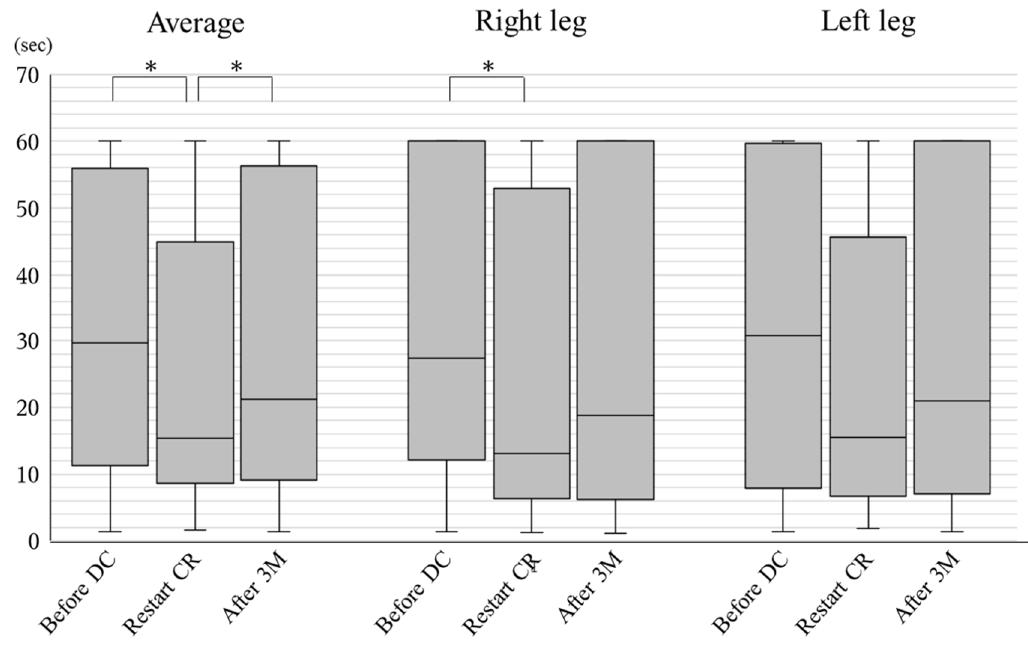
Figure 1. Changes in standing balance before DC, at restart of CR and after 3 months. The one-leg standing time with eyes open test was performed. The times for the right leg, left leg, and their average before discontinuation (DC), at restart cardiac rehabilitation (CR), and after 3 months (M) CR are shown. * indicates p <